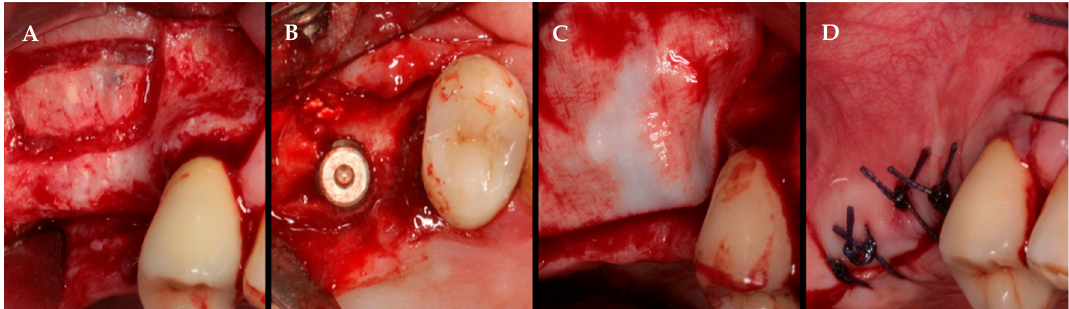
Figure 2. Augmented sinus by lifting and grafting with a particulate bone substitute with a lateral window approach: ( A ) Exposure of the crest with full-thickness flap with osteotomies; ( B ) dental implants placed in sinus lifted and grafted with xenogeneic bone substitute material; ( C ) surgical site covered by reabsorbable membrane; ( D ) clinical view of surgical procedure with final sutures of gingival margins.